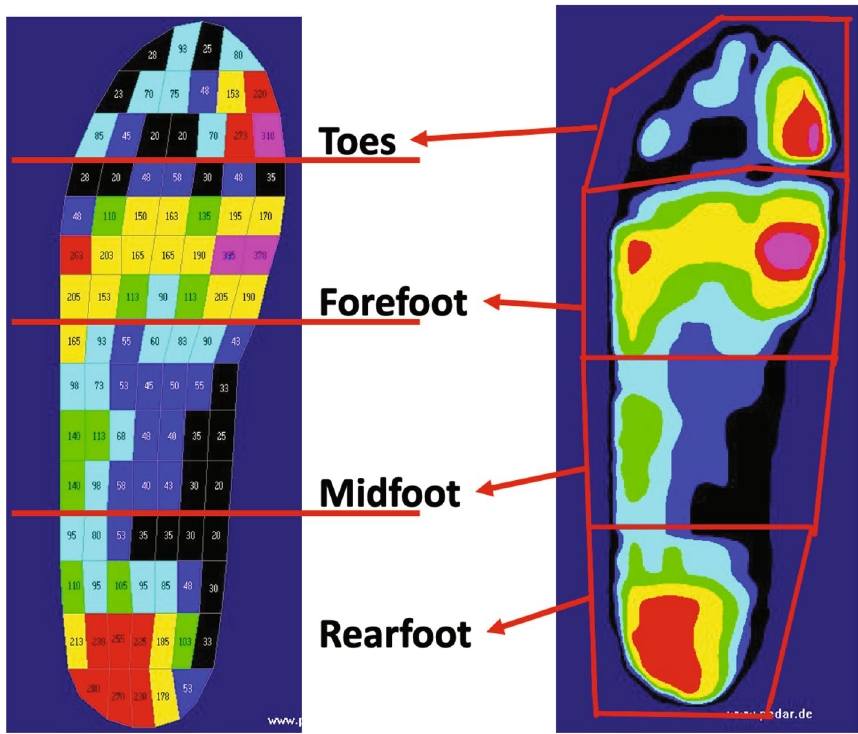
Figure 2. Four specific plantar